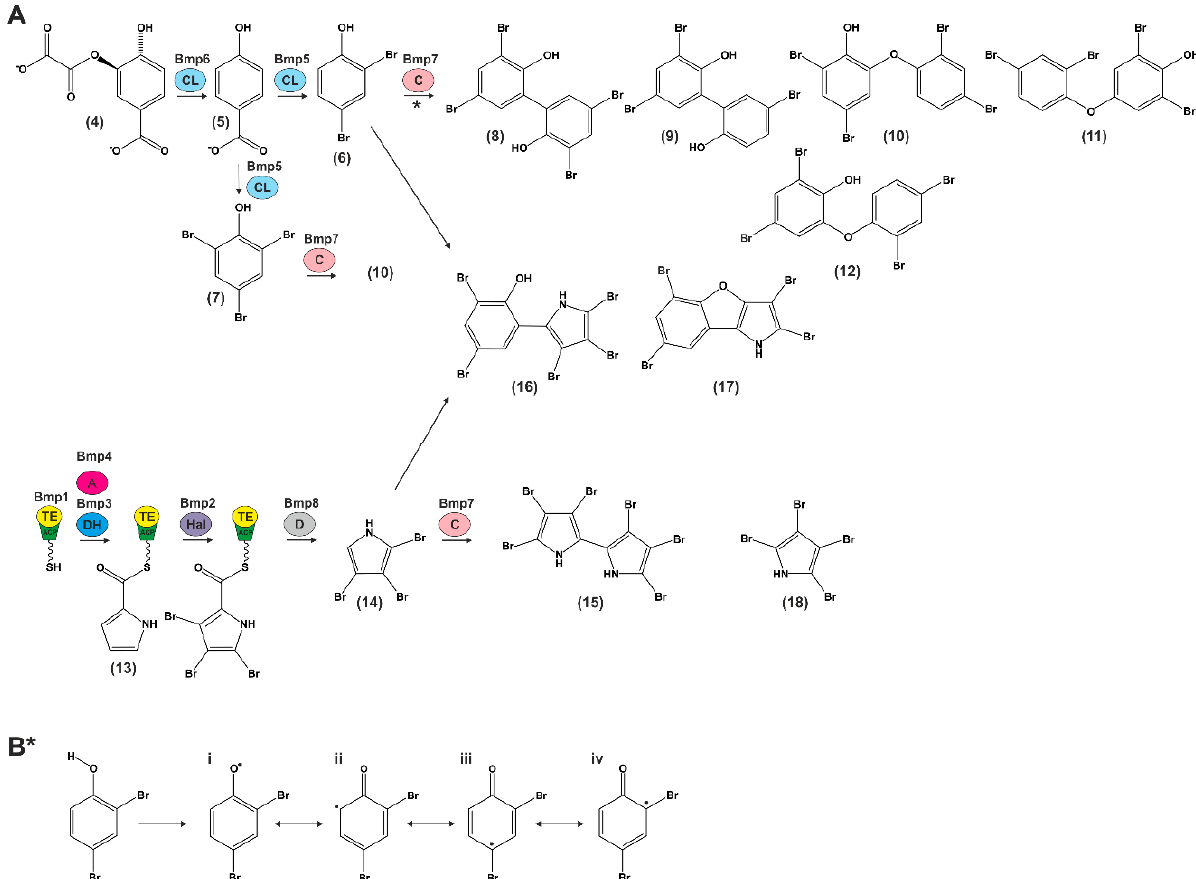
Figure 2. Bi-modular scheme for the biosynthesis of polybrominated marine natural products by the bmp pathway [22]. ( A ) Chorismate ( 4 ) converted to ( 5 ) by chorismate lyase (CL) Bmp6 and further to ( 6 ) and ( 7 ) by flavin-dependent halogenase Bmp5. The CYP coupling (C) enzyme Bmp7 generates different polybrominated biphenyls via the proposed steps in ( B* ), such as ( 8 )–( 11 ). Bromopyrroles are derived from L-proline, its acylation to the ACP domain (TE-ACP) of Bmp1 by proline adenyltransferase. (A) Bmp4 initiates its oxidation by the flavin-dependent dehydrogenase (DH) Bmp3. Followed by tribromination by the flavin-dependent halogenase (Hal) Bmp2. The TE domain of Bmp1 catalyzes the offloading of a carboxylic acid intermediate, which is decarboxylated (D) by carboxymuconolactone decarboxylase homolog Bmp8 to ( 14 ). ( 14 ) can be dimerized by Bmp7 to generate ( 15 ) and ( 18 ), or with ( 6 ) to generate heterodimers such as ( 16 ) and ( 17 ). ( B* ) Proposed steps for radical generation, rearrangement and coupling of ( 6 ) by Bmp7 to generate biphenyls and OH-BDEs. Adapted and modified from [22].